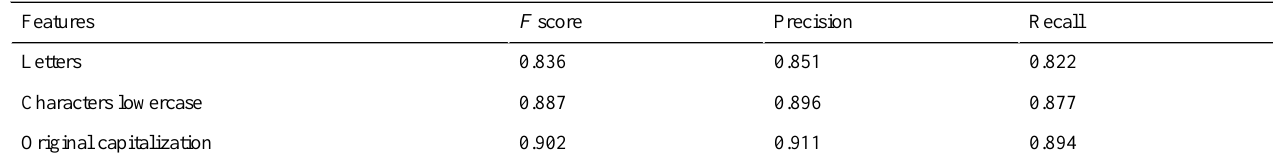
Table 4. Classification results for author identification on IVF/FET/IUI Cycle Buddies subforum; 10-fold cross-validation, 30 authors, 100 posts per author.